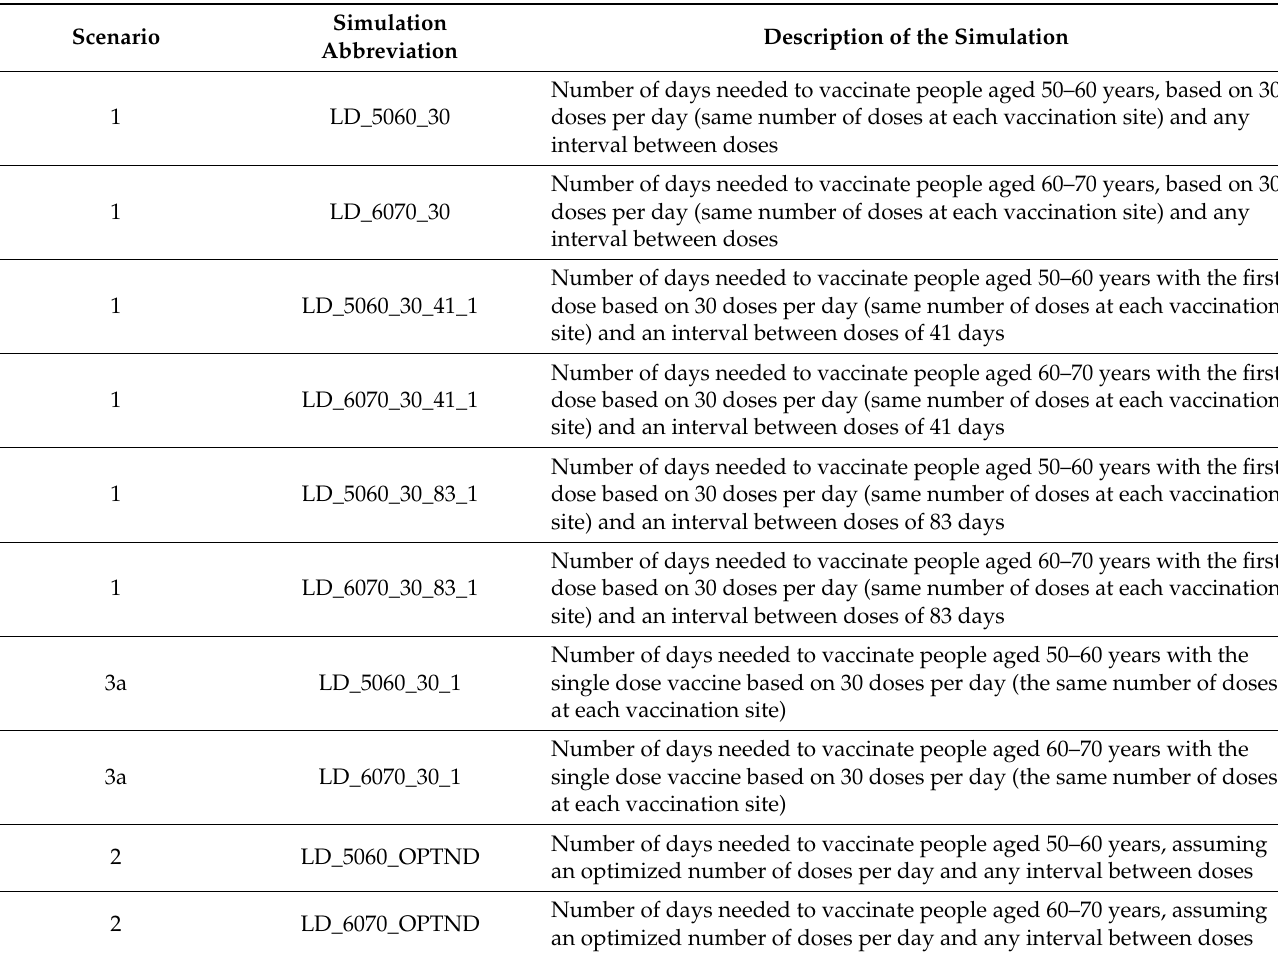
Table 1. Description of the simulations conducted under the three